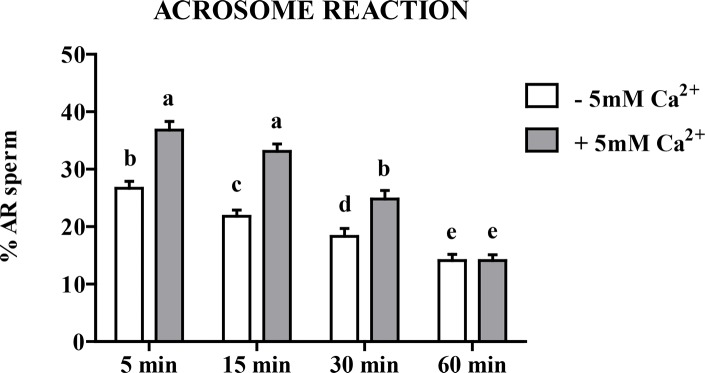
Effect of extracellular Ca2+ on chicken sperm AR.Sperm were incubated for up to 60 min at 35°C in medium not supplemented with Ca2+ (-5mM Ca2+, white bar) or containing 5mM Ca2+ (+5mM Ca2+, grey bar). The percentages of successful sperm AR after 5, 15, 30 and 60 min of incubation were determined as described in the Materials and Methods section. The results are expressed as mean ± SEM, n = 6. Different superscripts letters indicate statistically significant differences (P < 0.05).